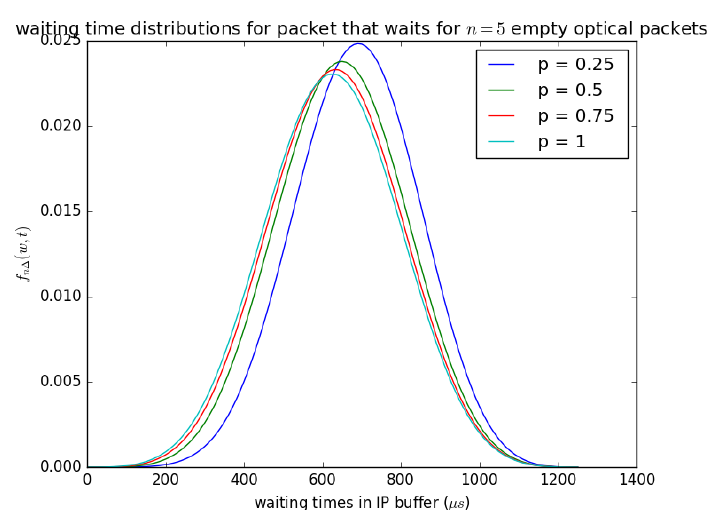
Figure 20. f W 5 ( w ) as defined in Equation (25); the influence of the probability p of the empty optical packet on the distribution of waiting time if n =